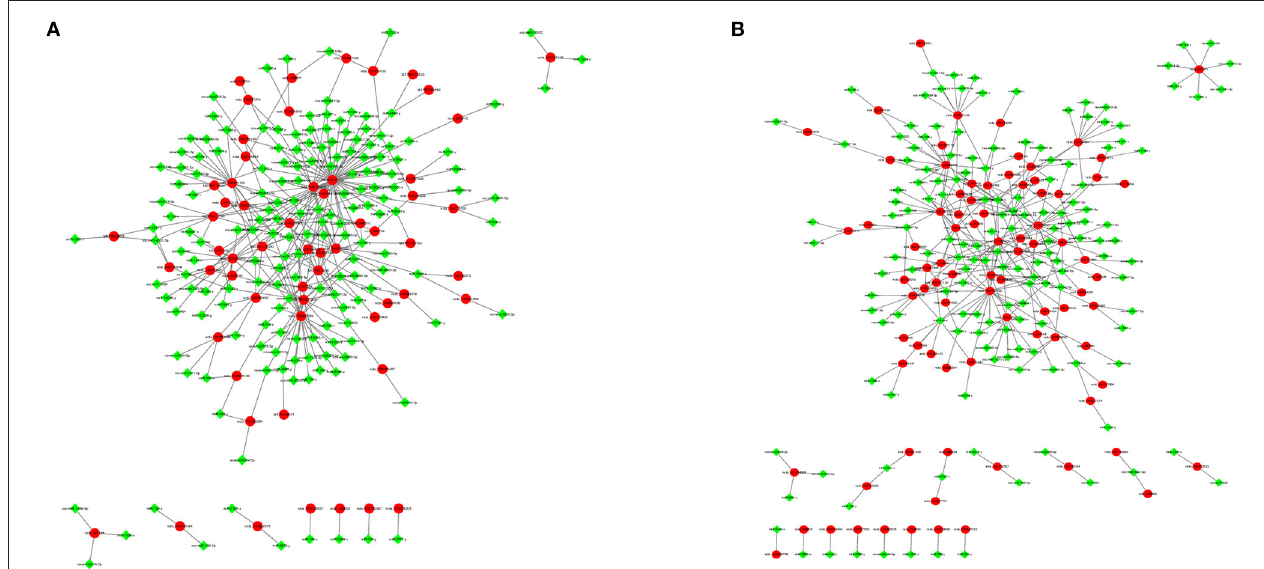
FIGURE 8 | Gene coexpression network analyses. Red nodes indicate hypoxic DEmRNAs, and green nodes indicate DEmiRNAs. (A) Gene coexpression network analyses of DEmRNAs and DEmiRNAs. (B) Gene coexpression network analyses of hypoxic DEmRNAs and DEmiRNAs.